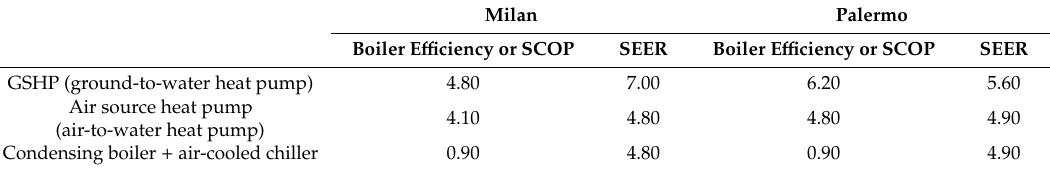
Table 5. Seasonal average energy e ffi ciency for the analysed solutions. Milan